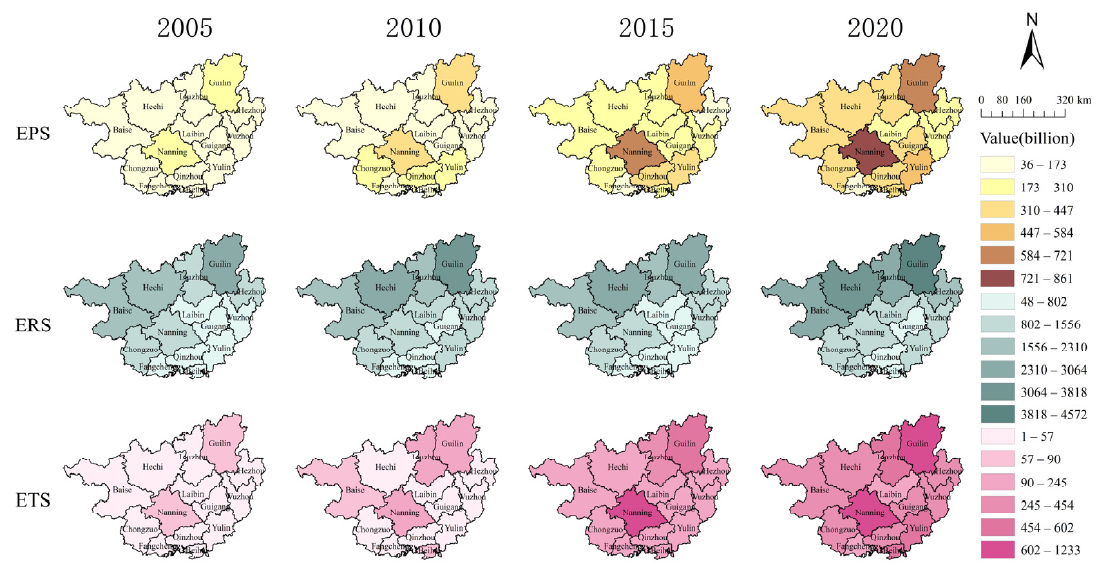
Figure 5. Spatial distribution of the monetary value of terrestrial ecosystem products from 2005 to 2020.